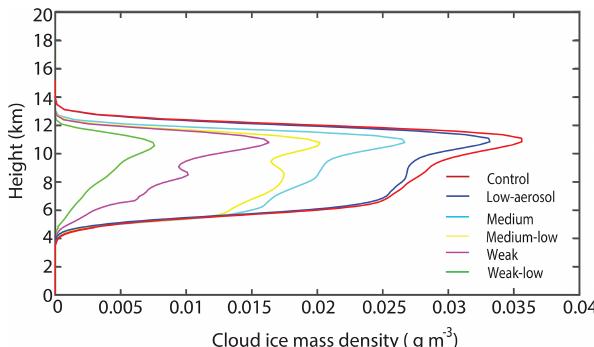
Figure 6. Vertical distributions of the average cloud-ice mass den- sity at all altitudes in cloudy areas (non-zero sum of LWC and IWC) over the simulation period between 17:00GMT on 5 August and 12:00GMT on 6